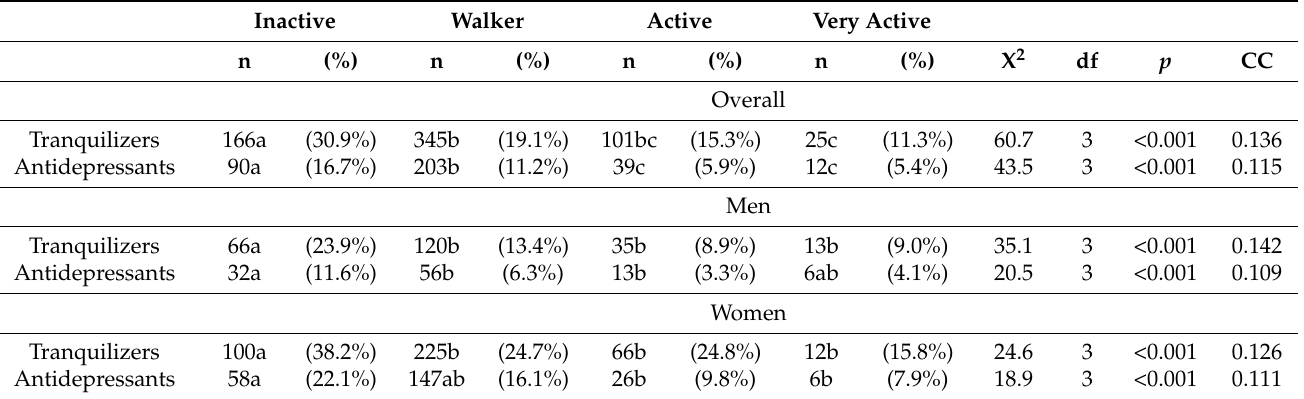
Table 1. Tranquilizer and antidepressant use according to the Physical Activity Level in Spanish people with Hypertension (ENSE2017).